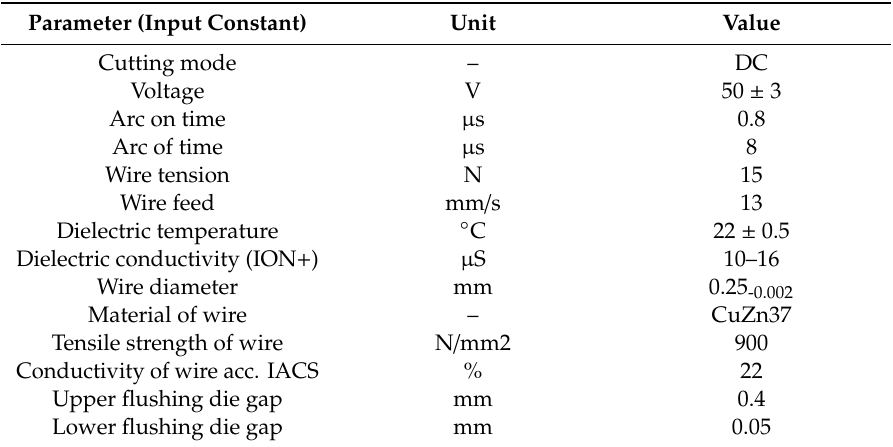
Table 2. Constant machining conditions in this research study.